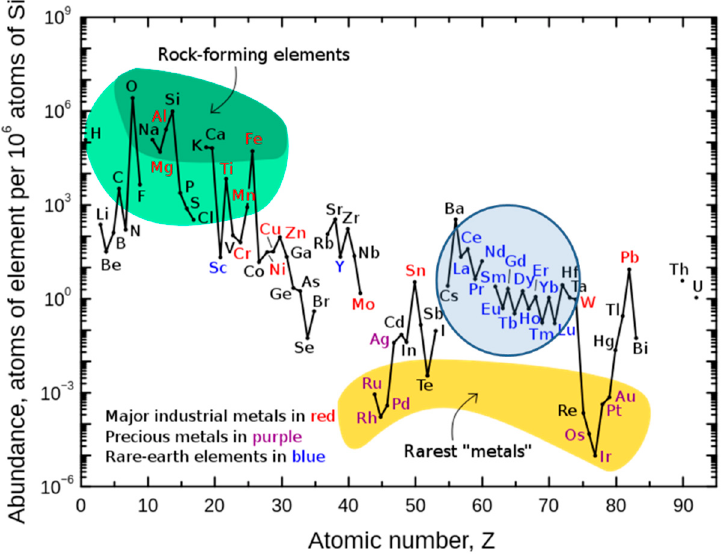
Figure 6. Natural abundance of elements. Source: https://en.m.wikipedia.org/wiki/Abundance_ of_elements_in_Earth%27s_crust (accessed on 26 June